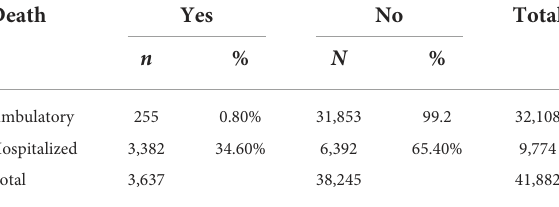
TABLE 2B Type of medical attention (deaths).